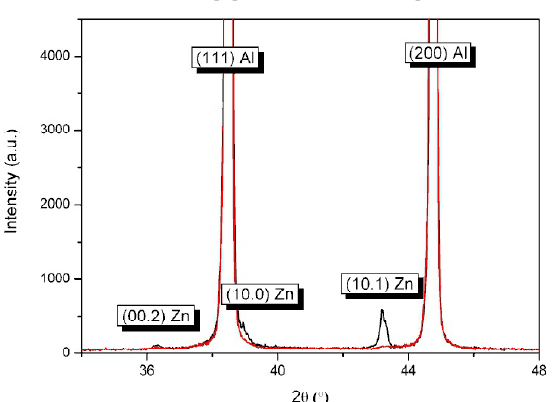
Fig. A1. XRD profiles of the Al-10Zn alloy after ECAP (black line) and after ECAP+SA (red line).